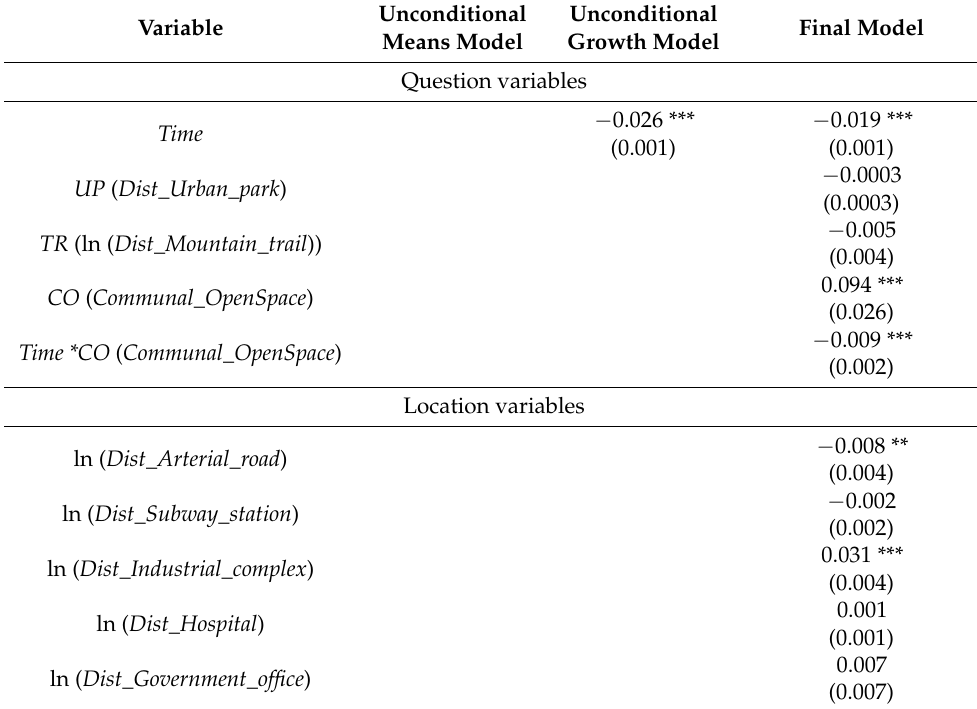
Table 2. Results of multilevel growth model including other